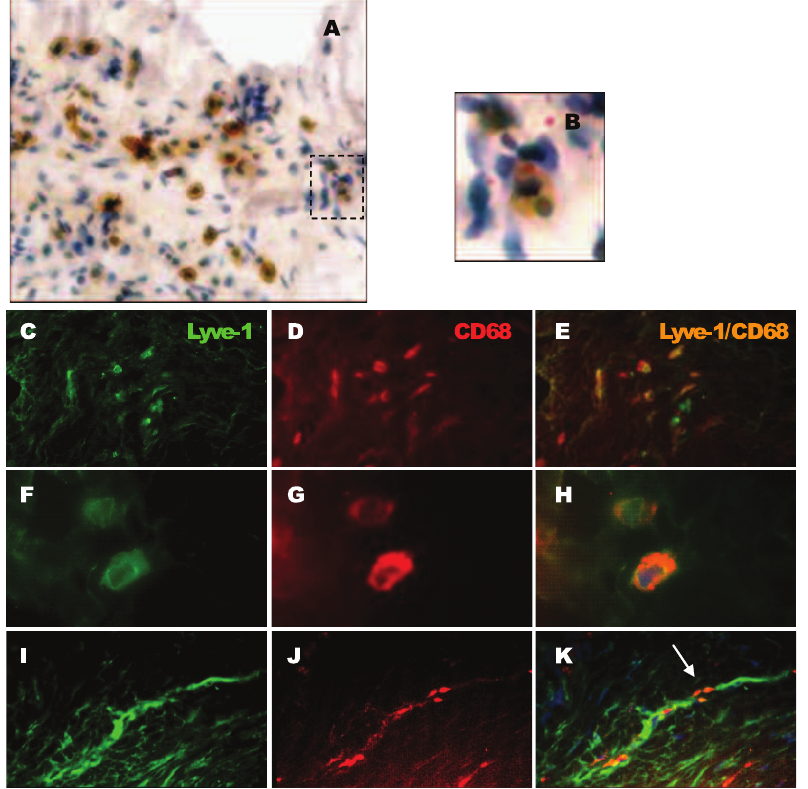
Figure 6. Lyve-1 + macrophages in nodule. (A) Individual Lyve-1 + mononuclear cells in the fibrous capsule of nodules. (B) Detail of a Lyve-1 + mononuclear cell phagocytising apoptotic neutrophil. (C–K) Double Immunostaining for Lyve-1/CD68 to establish the macrophage lineage of Lyve-1 + mononuclear cells: (C & F) Lyve-1 + mononuclear cells, (D & G) CD68 + macrophage, (E & H) merging C & D and F & G. (I–K) Incorporation of Lyve-1 + macrophages into lymphatics: (I) Lyve-1 + lymphatic vessel, (J) CD68 + macrophage, (K) merging I & J. Number of analysed nodules=10. Scales: A,B,F,G,H, bar=50 m m.